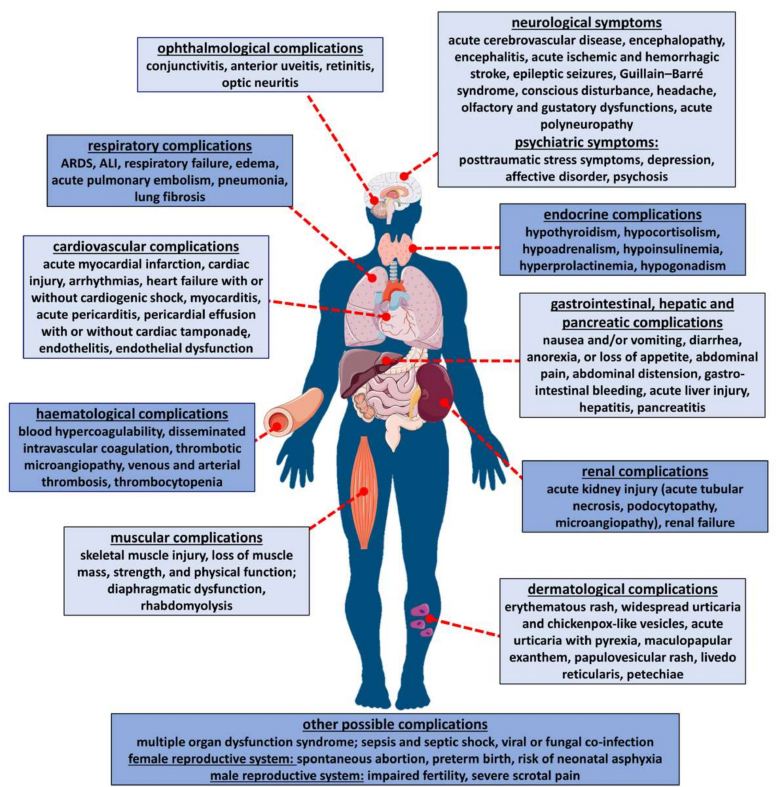
Figure 2. Systemic manifestation of COVID-19 infection. For respective literature, see Section 2. ALI, acute lung injury; ARDS, acute respiratory distress